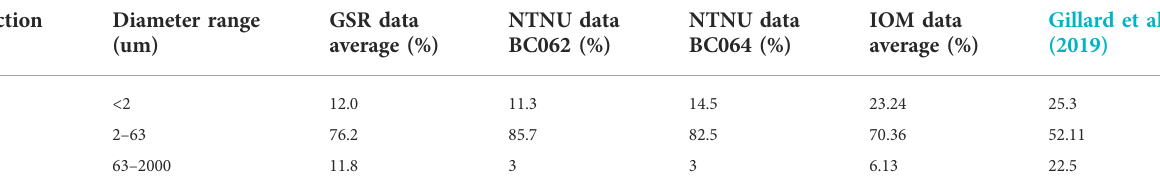
TABLE2Sedimentfractiondistribution:GSRandNTNUdata(Langetal.,2019),IOMdata(Zawadzkietal.,2020).GSRprovidesaverageddatabasedon the Belgium license area in the CCZ, while NTNU data is data of speci fi c box-cores of the GSR data average. The IOM data is based on data from the CCZ ’ s IOM license area.